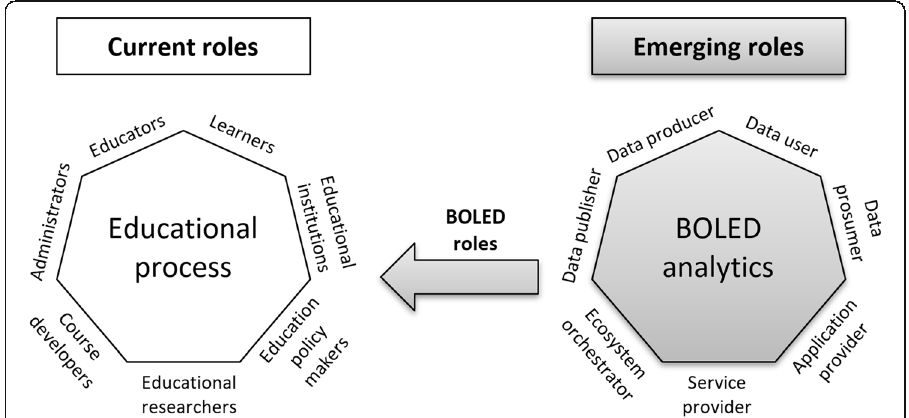
Fig. 5 The division of roles between current and emerging educational